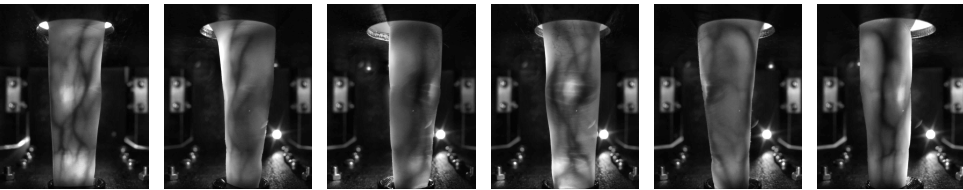
Figure 6. Multi-perspective finger vein dataset example images, from left to right: 0°, 60°, 120°, 180°, 240°, 300° (image originally published in